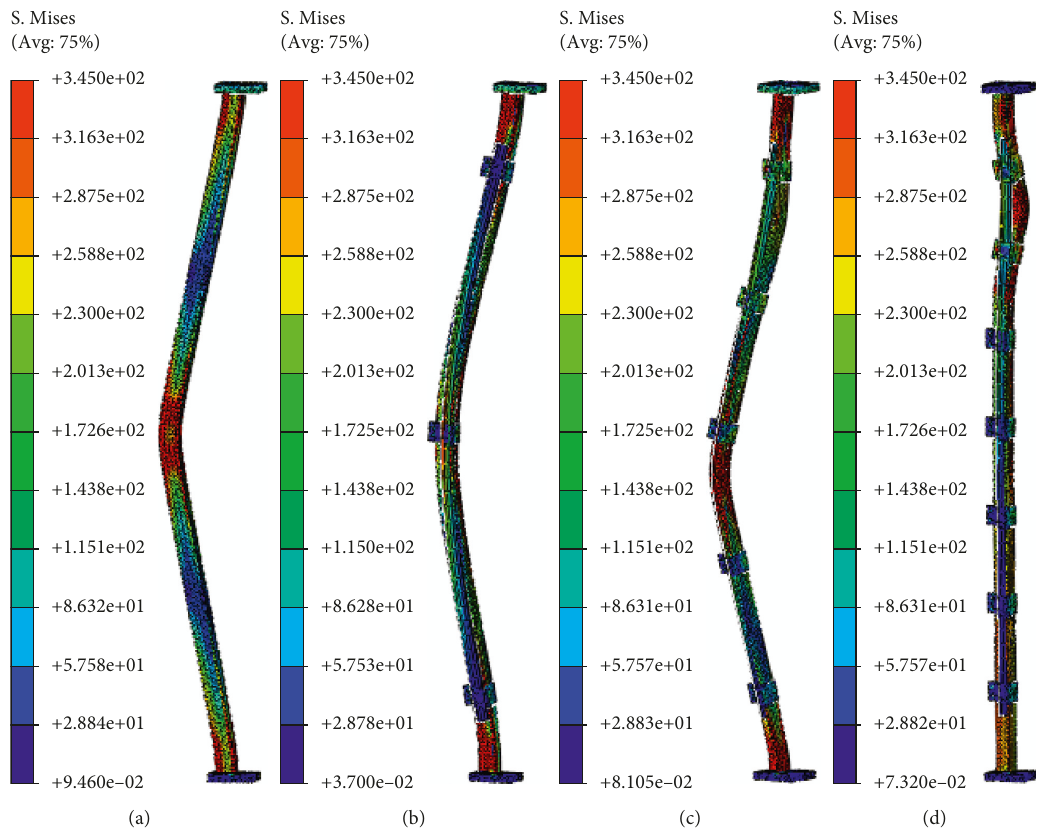
Figure 8: Member buckling shape (L100 × 10 mm). (a) L100 × 10G0SR75-0. (b) L100 × 10G57SR75-1150. (c) L100 × 10G57SR75-575. (d) L100 × 10G57SR75-385.